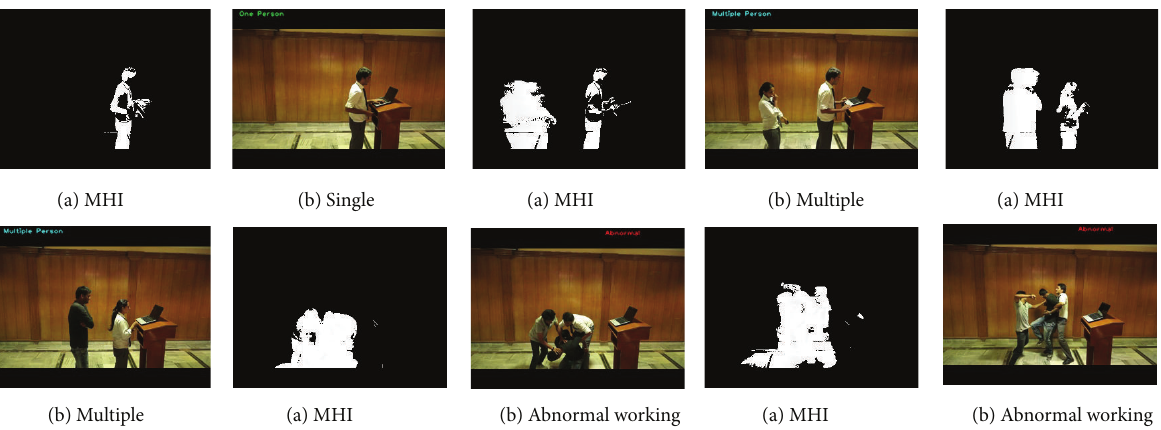
Figure 7: MHI of 15 frames (black and white (a)) and prediction by LibSVM (colored (b)) for each class (left to right).